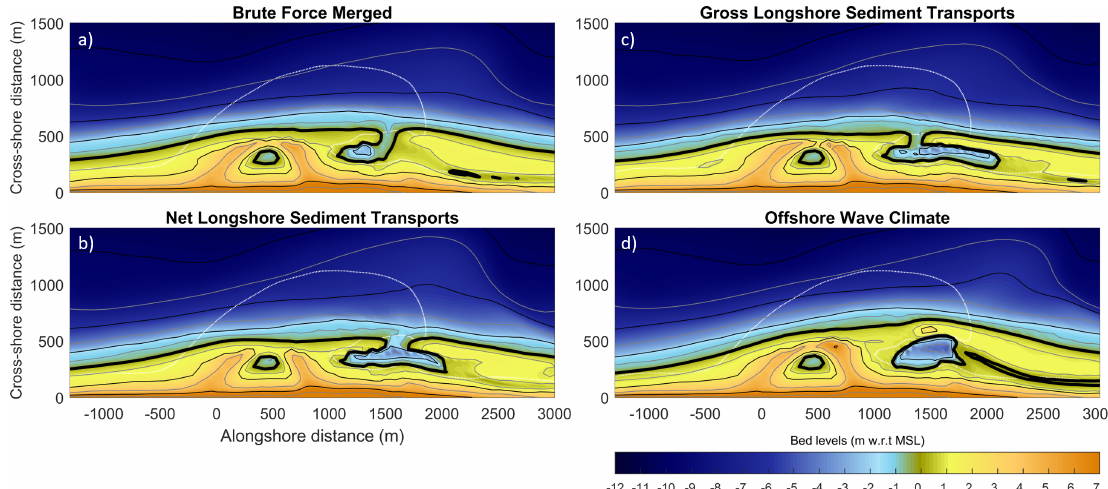
Figure 13. Computed bed levels in 2040 for the four considered acceleration techniques: ( a ) BFM, ( b ) NLST, ( c ) GLST, and ( d ) OWC. The white dotted line indicates the 2011 coastline just after ZM construction.